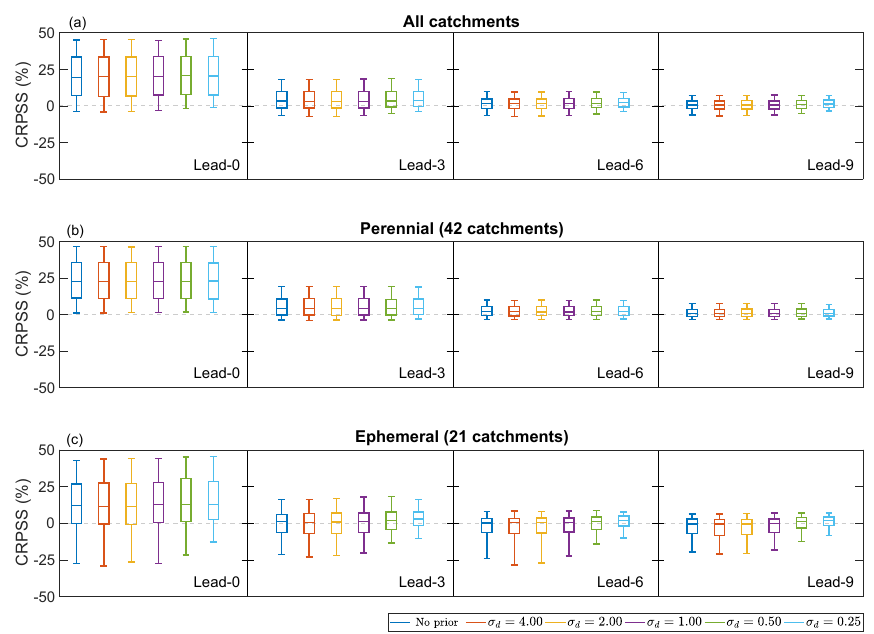
Figure 11. Skill (CRPSS) in 63 catchments by lead time for FoGSS forecasts with different strength priors on the d parameter (smaller values of σ d result in a stronger prior). For each lead time, forecast skill is summarized for all months with box and whisker plots. Boxes show the interquartile range with the median; whiskers give the 10th and 90th percentiles. (a) shows results for all catchments, (b) for perennial catchments only, and (c) for ephemeral catchments.